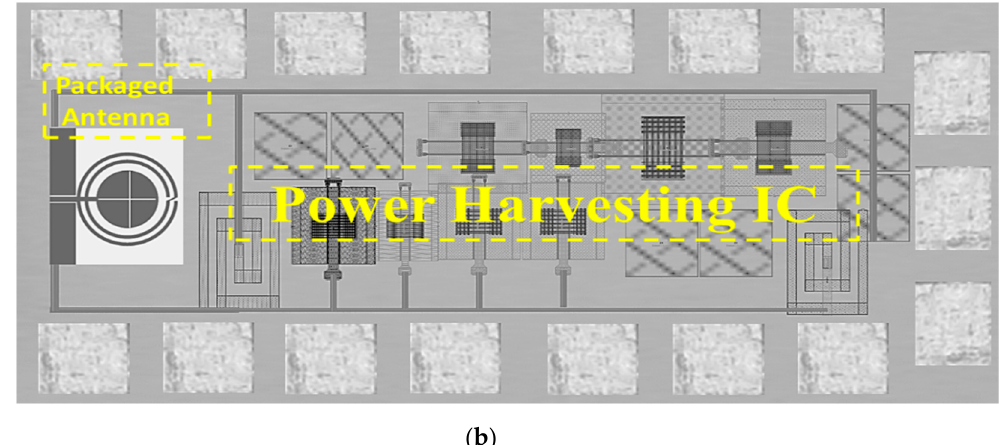
Figure 5. Proposed RF power harvesting circuit with its ( a ) schematic and ( b ) die microchip photograph (including on-chip antenna).